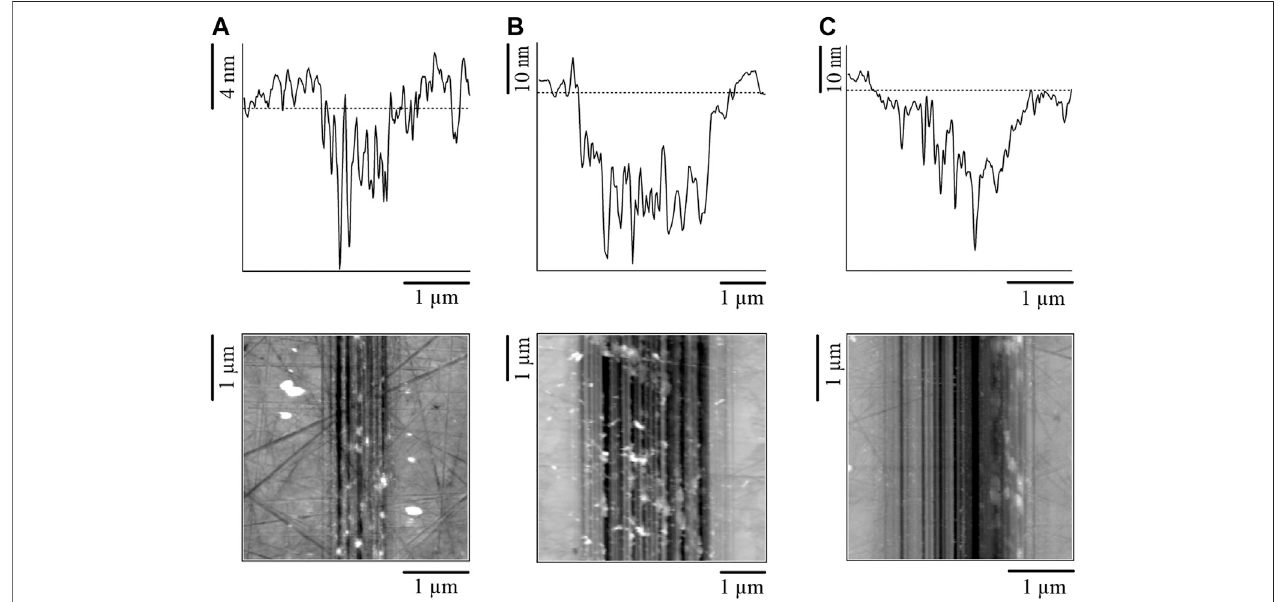
FIGURE2| Examplesofthreedifferentcategoriesofscarmorphologies.Theupper rowshowslinepro fi les,thebottomrowdetailsofthetopographies.Separated scratches[ (A) , Δ Z (cid:1) ± 10 nm],asingledepressionwithscratchesinside[ (B) , − 35 nm < Δ Z < 15 nm],and scratches nexttoandwithinadepression[ (C) , − 30 nm < Δ Z < 20 nm] can be